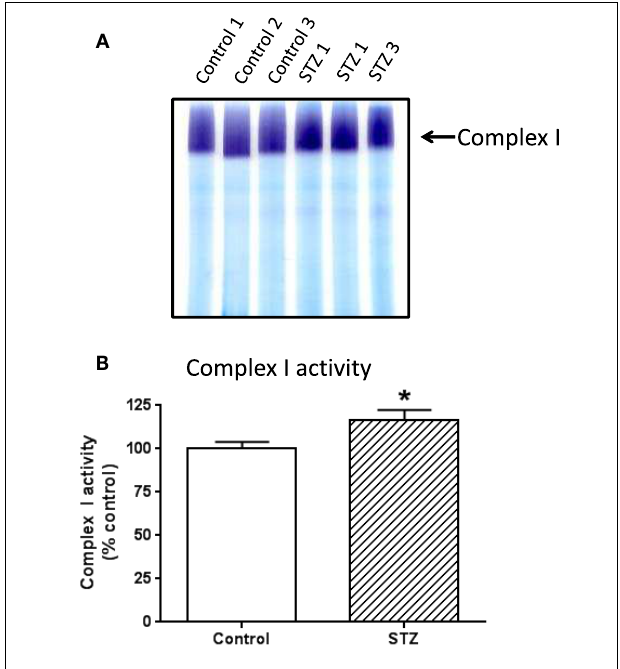
facilitate band matching and excision between stained gels and Western blot membranes as no other complexes were present.